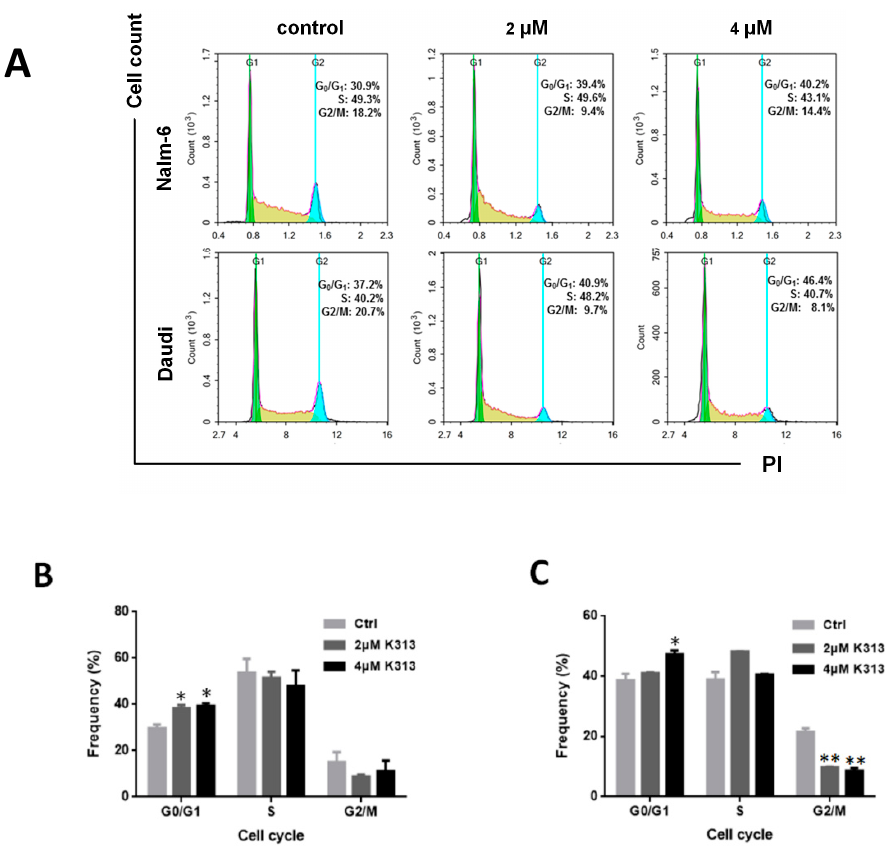
Figure 2. K313 induces Nalm-6 and Daudi cell cycle arrest moderately at the G0/G1 phase. ( A ) Nalm- and Daudi cells were treated with di ff erent concentrations of K313 for 24 h. The cells were washed, 6 and Daudi cells were treated with different concentrations of K313 for 24 h. The cells were washed, fixed, and stained with PI and analyzed for DNA distribution by flow cytometry. The percentages of fixed, and stained with PI and analyzed for DNA distribution by fl ow cytometry. The percentages of ( B ) Nalm-6 cells and ( C ) Daudi cells in di ff erent phases of the cell cycle are shown. The corresponding ( B ) Nalm-6 cells and ( C ) Daudi cells in different phases of the cell cycle are shown. The corresponding percentage values of Nalm-6 and Daudi cells in the G0 / G1, S, and G2–M phase were calculated. percentage values of Nalm-6 and Daudi cells in the G0/G1, S, and G2–M phase were calculated. * p < * p < 0.05 and ** p < 0.01 vs. control (0.1% DMSO) 0.05 and ** p < 0.01 vs. control (0.1% DMSO) group.